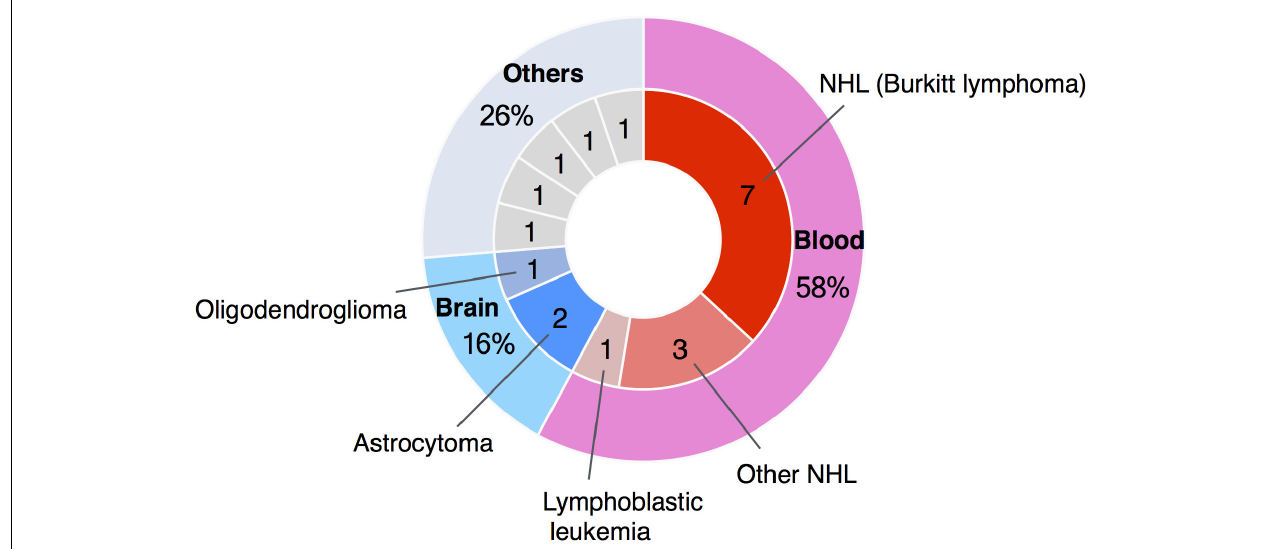
FIGURE 2 | Summary of case reports of tumors in WBS patients. The number of reported cases of blood cancer in patients with WBS has reached 11, and seven of these were cases of Burkitt lymphoma.